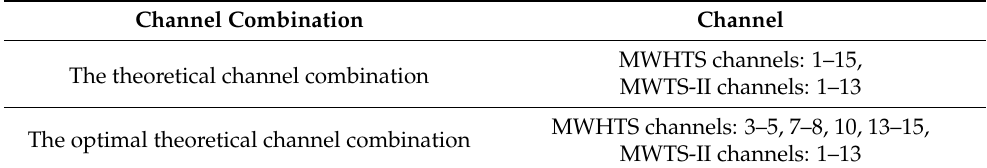
Table 5. Channel combinations for the fusion retrieval of SSP from MWHTS and